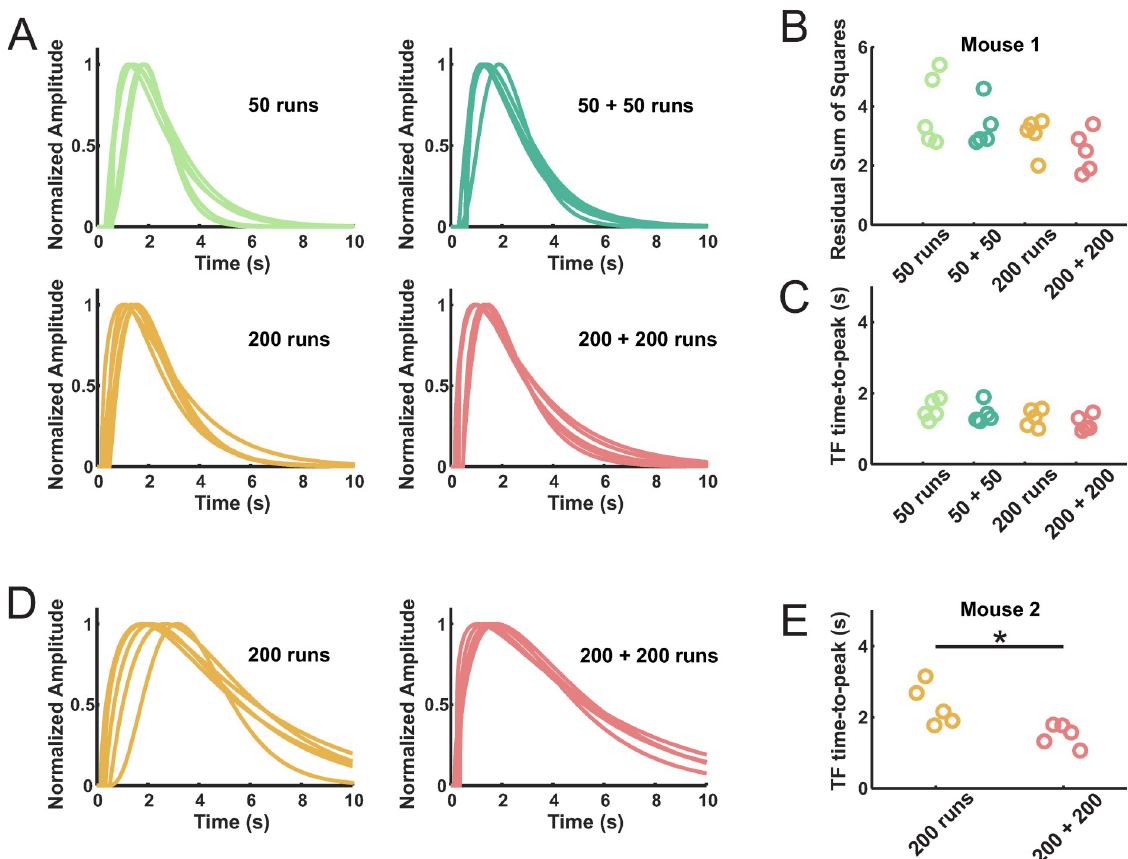
Fig 4. Influence of the number of runs and iterations on the TF shape and quality. (A) Using the Simulated Annealing algorithm, we tested 4 protocols of 50 or 200 optimization runs, either done a single time or repeated (5 TFs computed for each protocol). (B) Residuals of the cost function do not significantly differ across the protocols, although the protocols with the highest number or runs show a trend of smaller residuals. (C) Similarly, there was no significant difference for TFs time-to-peak values. (D, left) Same protocols comparison on a dataset from a different mouse revealed a sparse dynamic of optimized TFs, even if the best TFs were selected on a pool of many TFs (200 runs). (D, right) A second iteration of 200 runs gave more homogeneous TFs dynamics. (E) Quantification of the dynamic heterogeneity was made by measuring the time-to-peak which resulted in a scattered distribution for the 200 runs protocol, packed up repeating the same iteration a second time. Residual values, not reported in this figure, were not significantly different for mouse 1 and